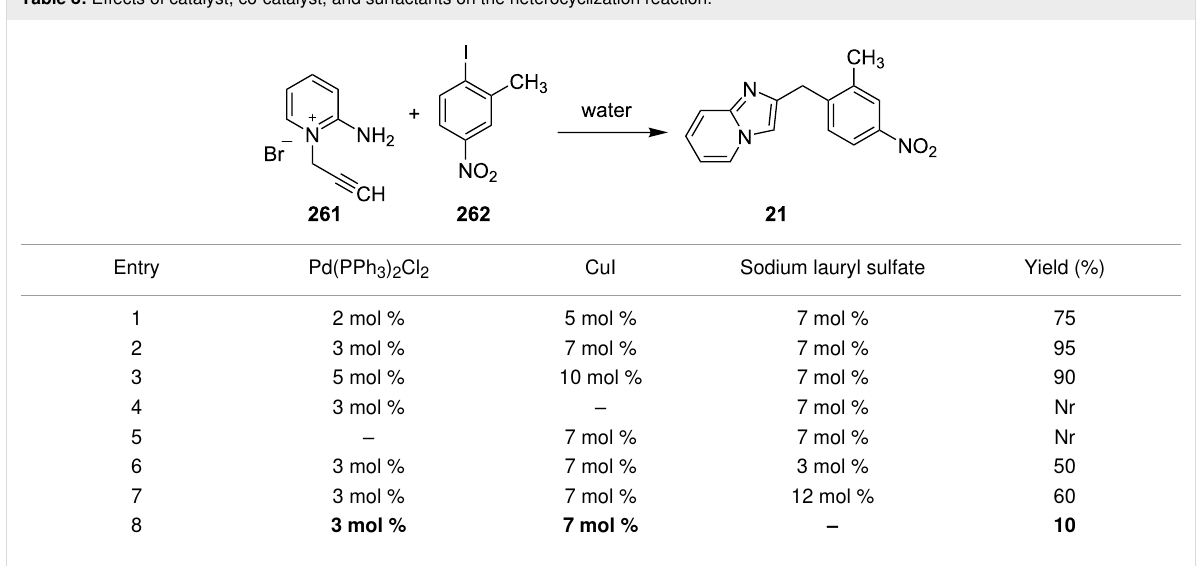
Table 8: Effects of catalyst, co-catalyst, and surfactants on the heterocyclization